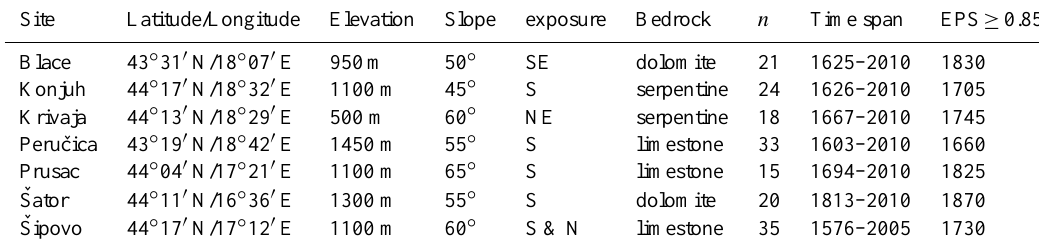
Table 1. General characteristics of sampled sites and number of trees sampled ( n ) in Bosnia and Herzegovina.